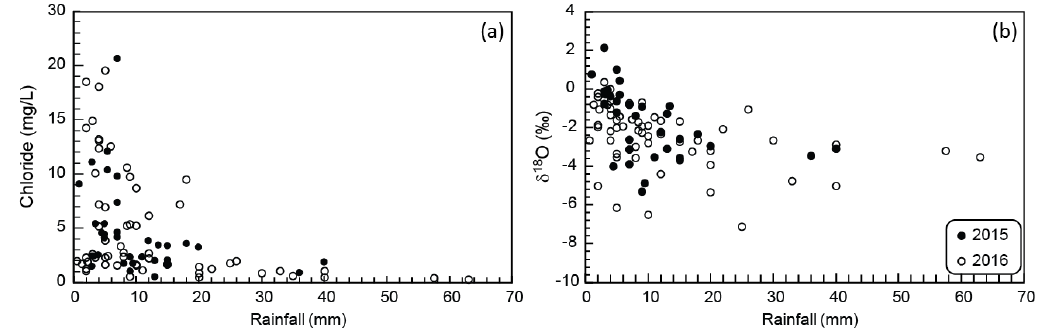
Figure 5. Relationship between ( a ) chloride concentration and ( b ) δ 18 O ratio and rainfall volumes for the sampling period. the sampling